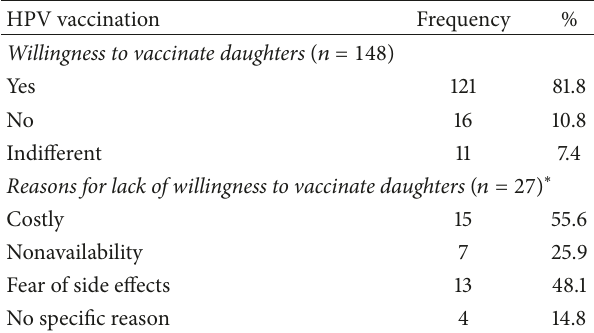
Table 4: Acceptance of HPV vaccination by